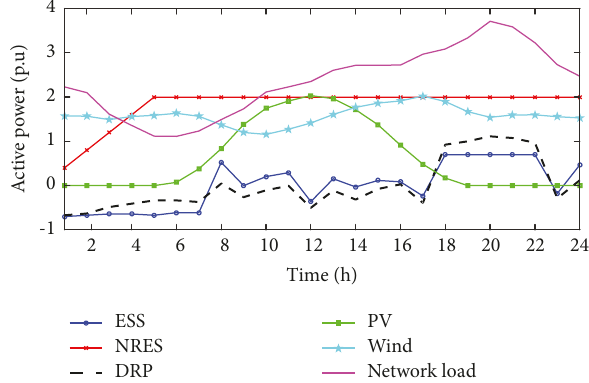
Figure 8: Daily expected total active power curve of different devices in the SDN.